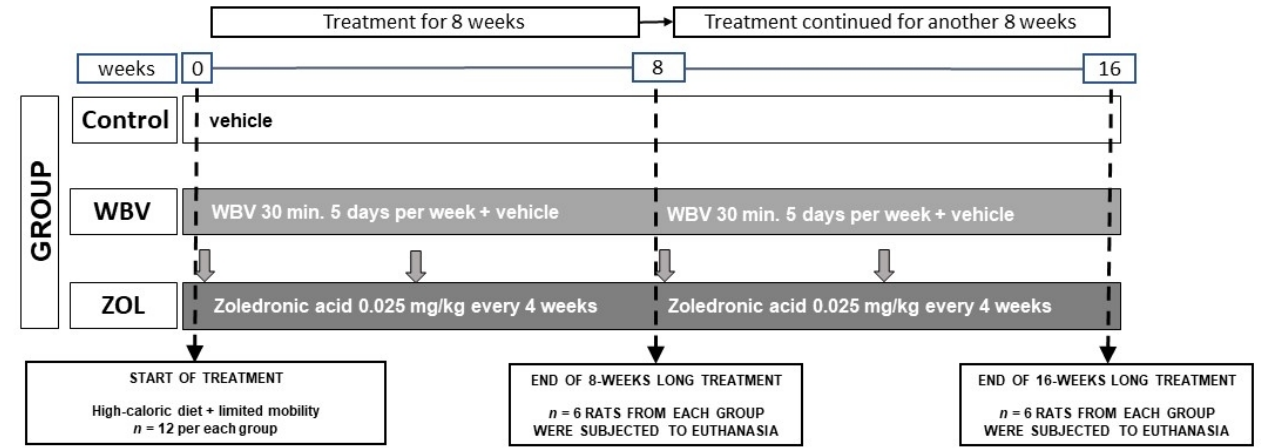
Figure 1. Scheme of the experimental design. Rat from all groups were fed a high ‐ calorie diet and kept in limited mobility conditions. Rats from the WBV group were subjected to whole ‐ body vibration treatment (30 min, 5 days per week), while rats from the ZOL group were injected intramuscularly with zoledronic acid at a dose of 0.025 mg/kg body weight every 4 weeks. Rats from the Control and WBV groups were injected with the vehicle (0.9% NaCl) at the same volume. Vertical gray arrows show the time of injections. At the end of the 8 ‐ or 16 ‐ week ‐ long treatment, n = 6 animals from each group were euthanized.